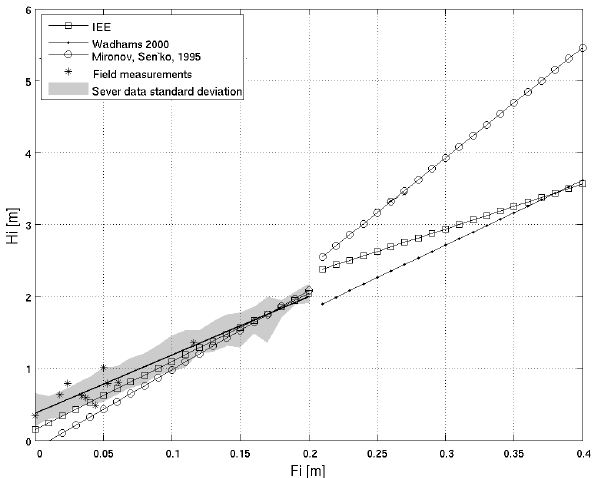
Fig. 4. Relation between ice thickness and ice freeboard based on measurements from the Sever expeditions (Eq. 1, standard deviation is shown as the grey zone); North Pole-29 drifting station (Mironov and Sen’ko, 1995) (Eqs. 8 and 9); Wadhams et al. (1992) (Eq. 10); and hydrostatic equilibrium equation (IEE) for FY and MY ice used in this study (Eqs. 6 and 7). The asterisks represent other direct measurements of thickness and freeboard obtained by the authors in 2004 and 2006.